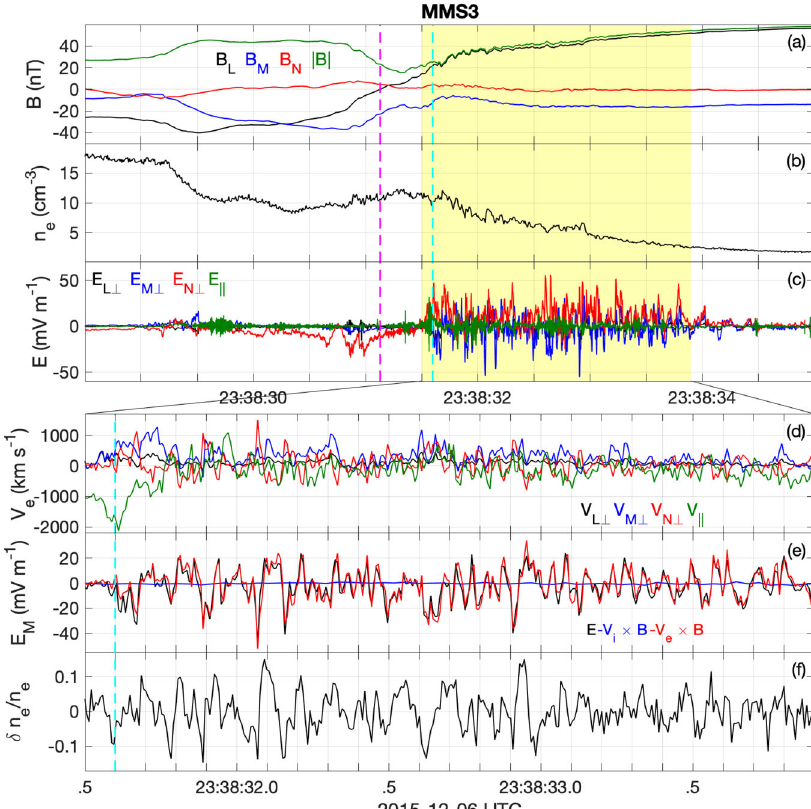
Fig. 2 Magnetopause crossing. Observations of the magnetopause current sheet by MMS3, including lower hybrid waves and associated electron fl uctuations. The waves occur at the sharpest density gradient on the low-density side of the boundary [indicated by the yellow shaded region in panels ( a – c )], and the electrons move together with the waves (i.e., are approximately frozen in). The spacecraft moves from the magnetosheath to the magnetosphere, and the neutral point is indicated ( B L = 0, dashed magenta line). The data are displayed in LMN coordinates (see text). a The magnitude and components of the magnetic fi eld B . b Electron density n e . c Electric fi eld E perpendicular to B in the LMN-directions ( E L ⊥ , E M ⊥ , and E N ⊥ ) and parallel to B ( E ∥ ). d Electron bulk velocity in the same directions. e E and the ion and electron convection terms in the M direction. f Normalized density fl uctuations δ n e / n e . The cyan dashed line indicates the magnetospheric separatrix, which is the boundary between magnetospheric and reconnected fi eld lines. The separatrix was identi fi ed by the strong electron jet directed away from the X line, as described in ref. 28 and seen in panel ( d